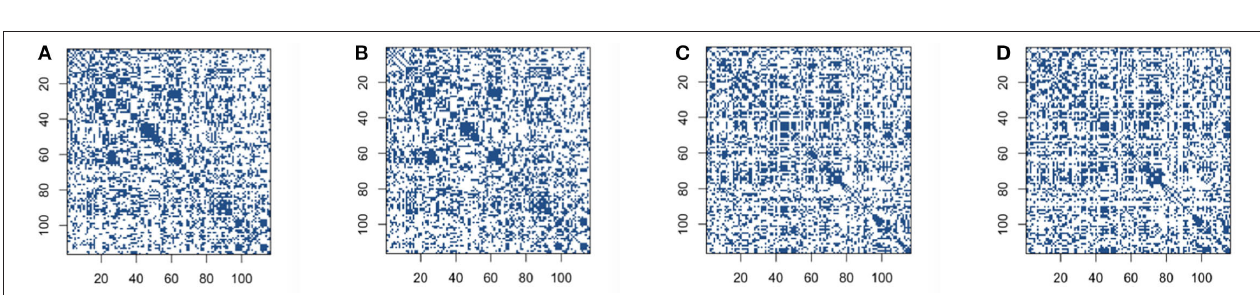
FIGURE 2 | Connectivity selection results for the control and AD groups from correlation with thresholding: (A) control group based on original blood oxygen level dependent (BOLD) signals; (B) control group based on low-rank matrix; (C) Alzheimer’s disease (AD) group based on original BOLD signals; (D) AD group based on low-rank matrix.